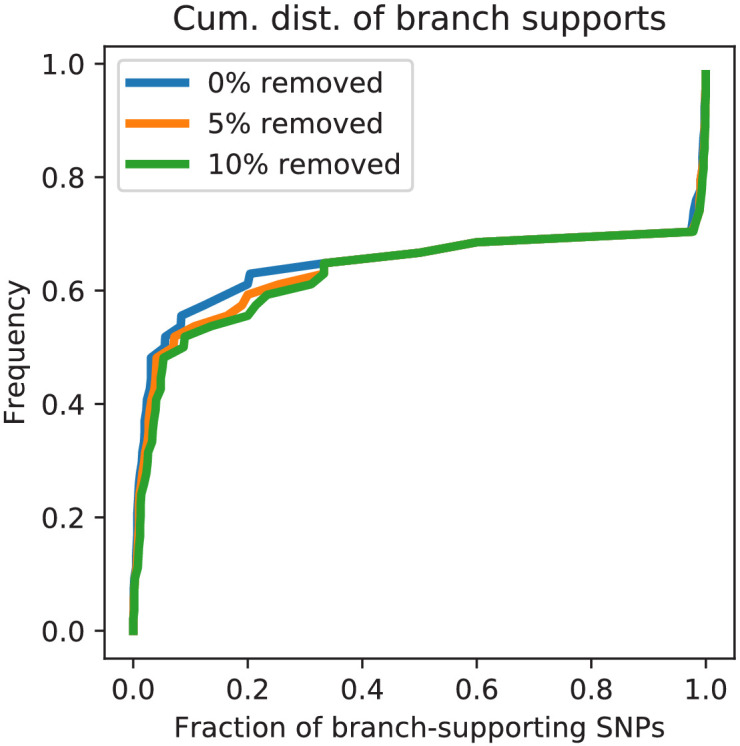
Homoplasies do not significantly effect the fractions of supporting SNPs for E.coli.Cumulative distribution of the fraction of supporting SNPs across all branches of the core tree for the original alignment of E. coli strains (blue) as well as for alignments from which 5% (orange) and 10% of potentially homoplasic columns were removed. The fact that the curves are almost identical shows that the distribution of SNP support is highly insensitive to a small fraction of homoplasies among the SNPs.